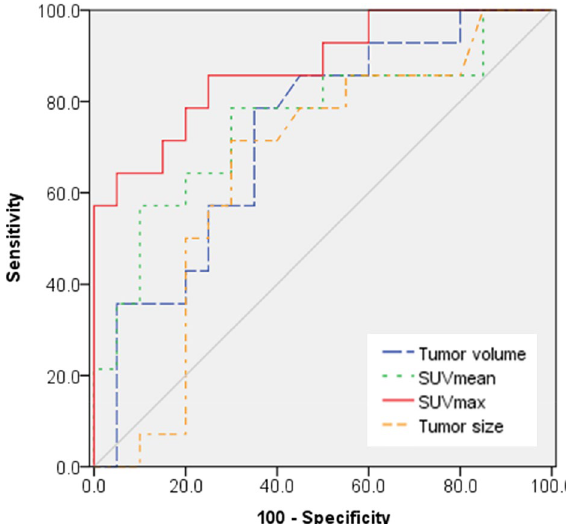
Figure 1. Receiver operating characteristic curves for tumor size, tumor volume, SUVmean, and SUV max for discriminating grade I chondrosarcoma from enchondroma.